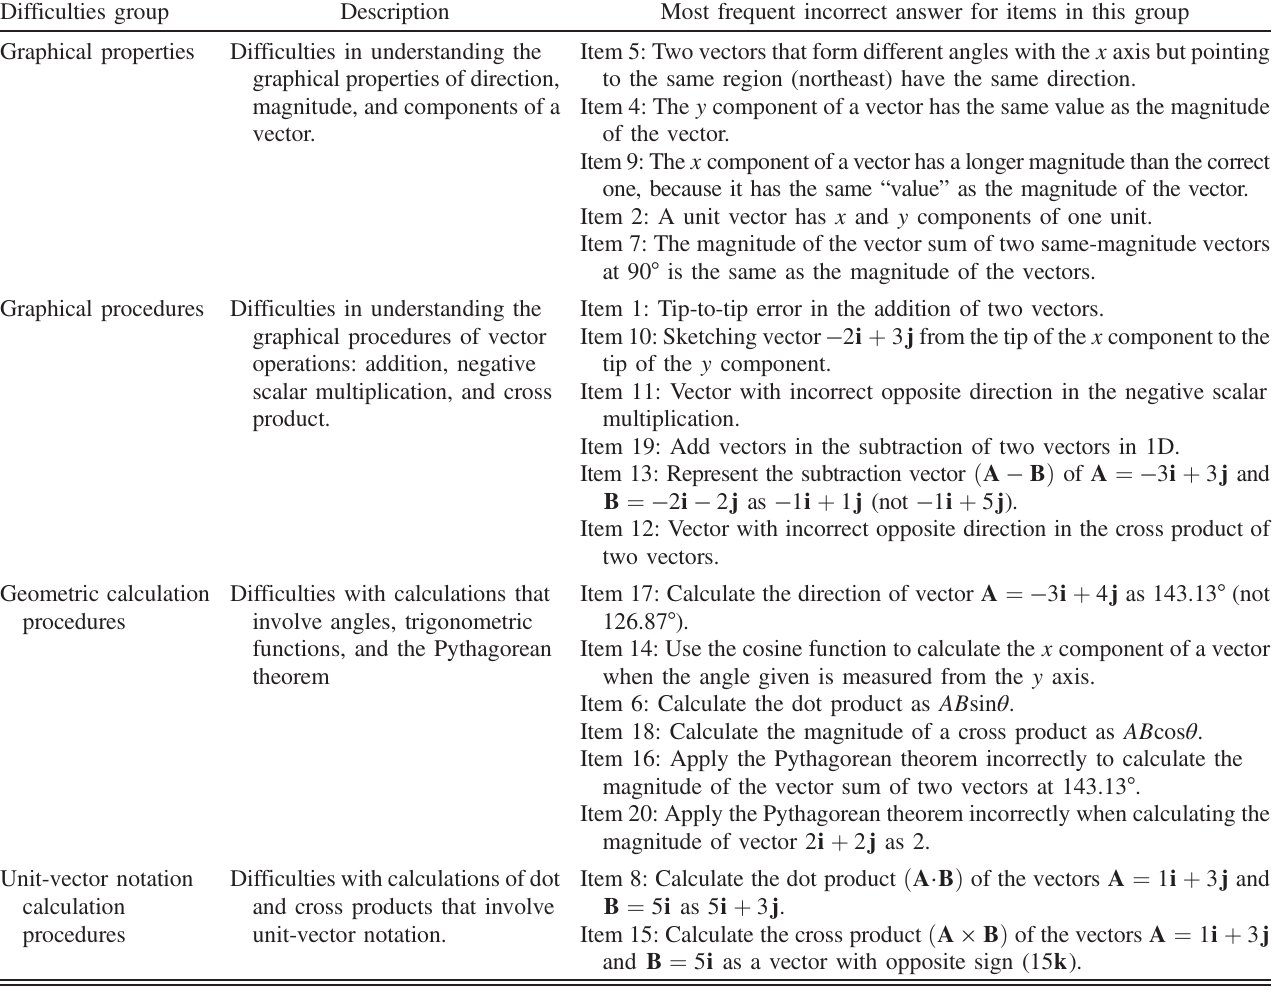
TABLE VI. Classification of the most frequent incorrect answer for each of the items of the TUV. Note that the most frequent incorrect answer of the dot product interpretation problem (item 3) cannot be classified in a specific group because of the peculiar nature of the dot product